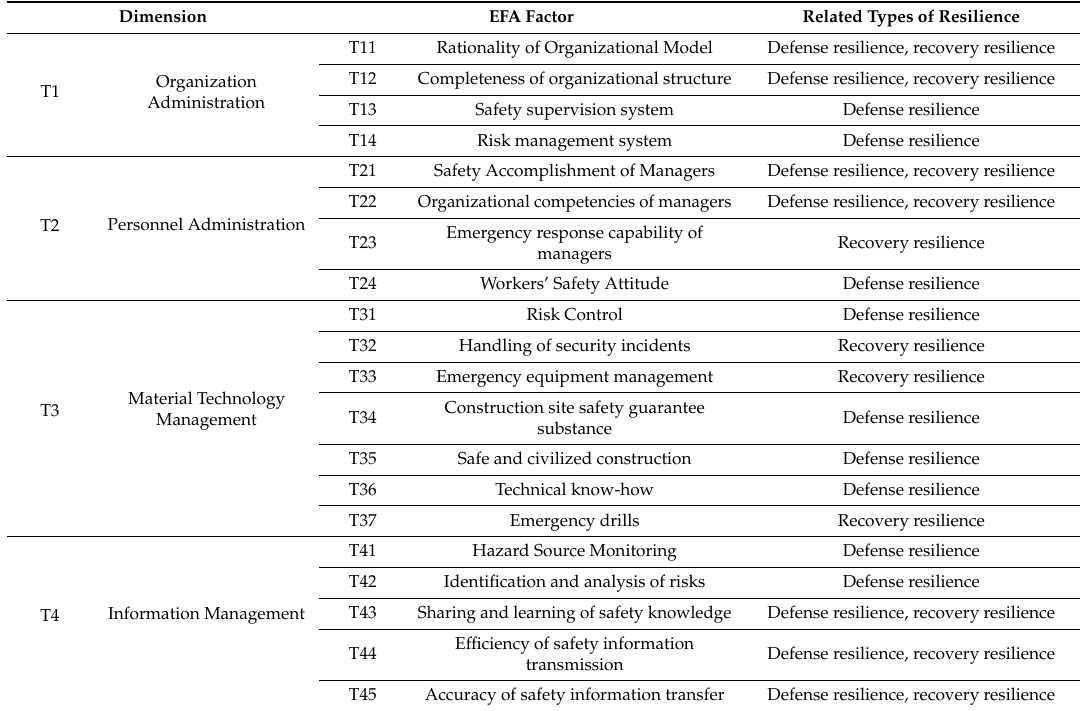
Table 6. Results of exploratory factor analysis (EFA) of influence factors of construction safety